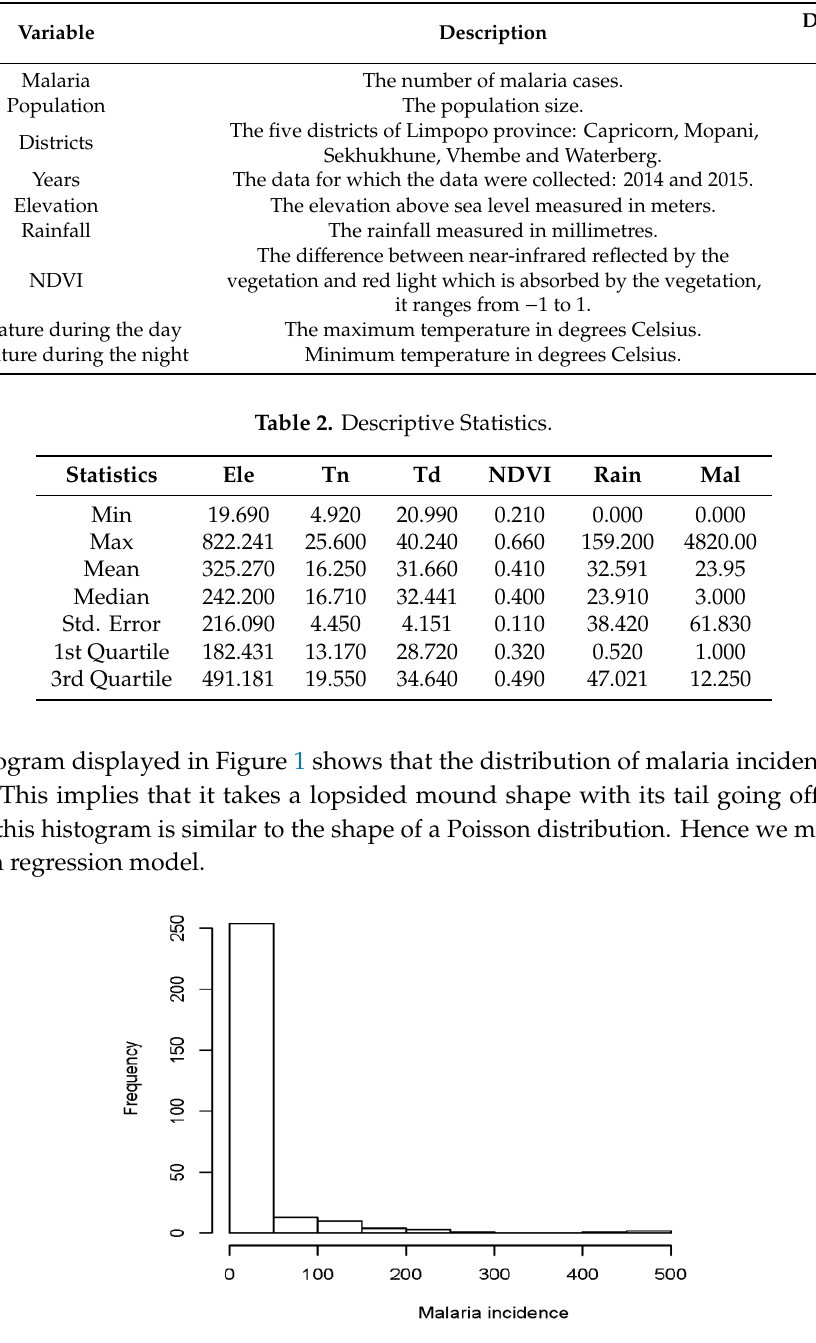
Figure 1. The distribution of malaria incidence in the Limpopo province.